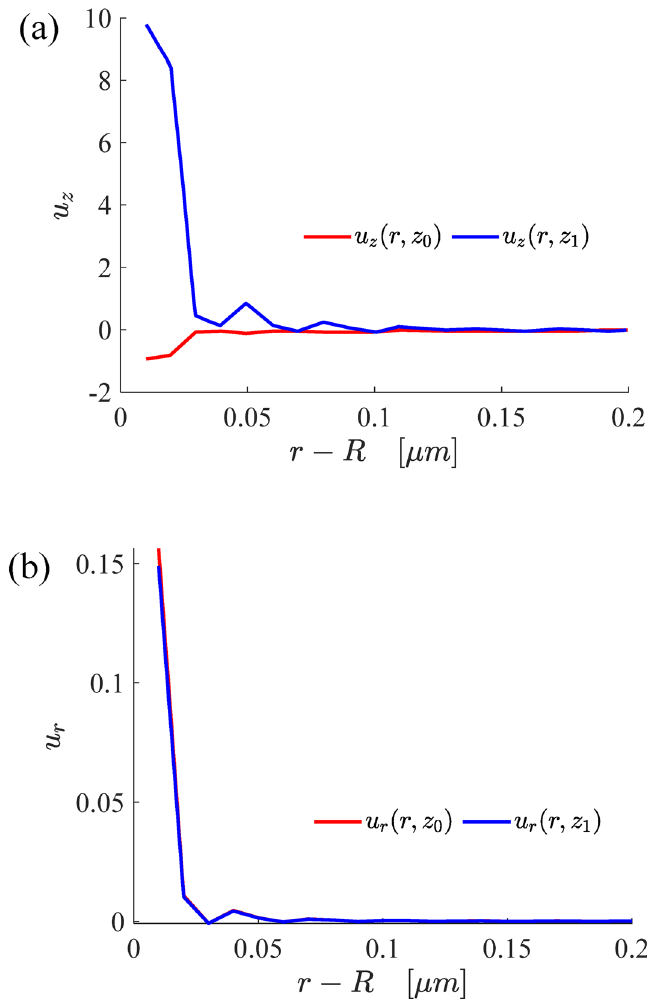
Figure 6. The variations of the normal ( a ) and radial ( b ) displacements of surface and inter-layer